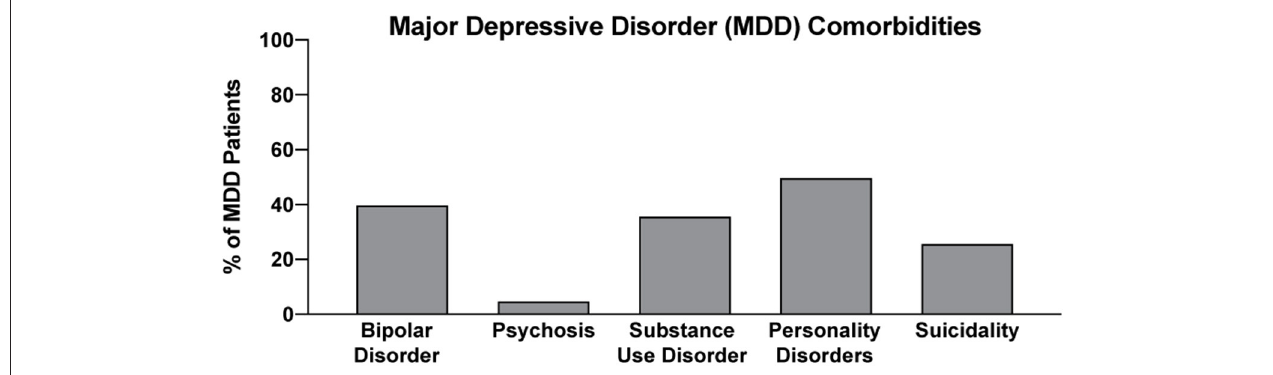
FIGURE 5 | Percentage of MDD with various comorbidities. Data for bipolar disorder, psychosis, substance use disorder, personality disorders, and suicidality were obtained from references (267–271),